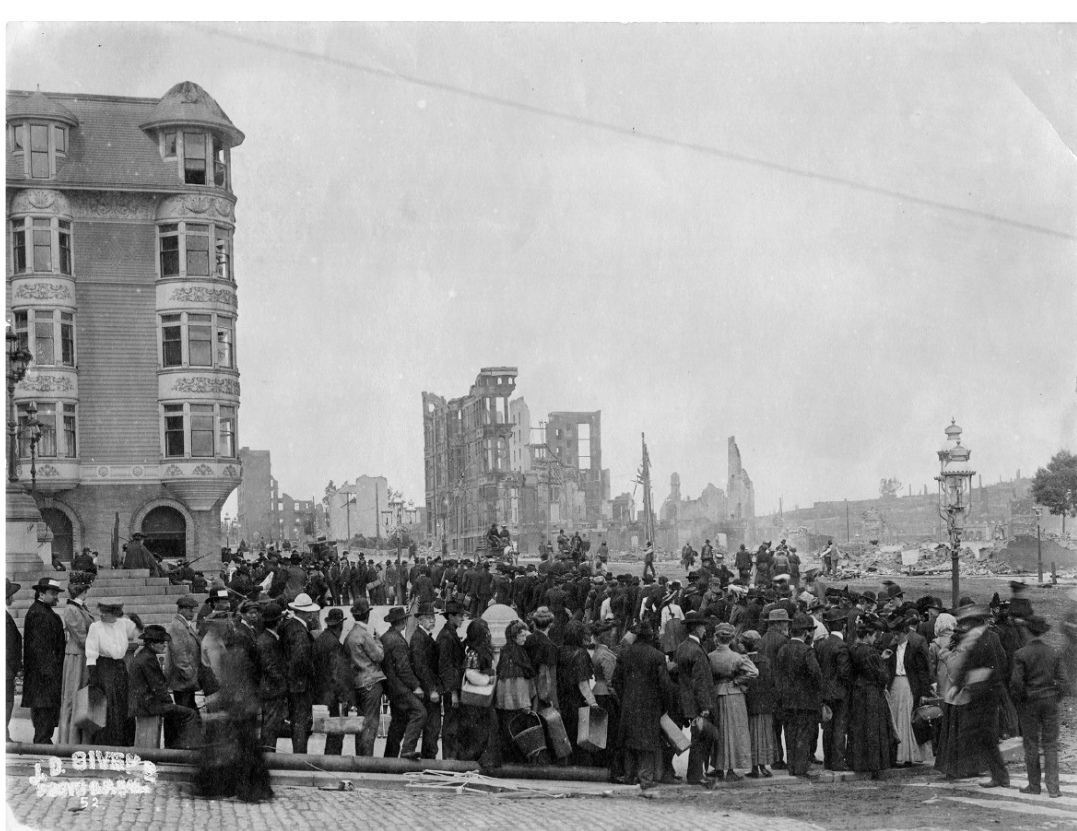
Figure 2: 1906 photograph showing a bread line at St. Mary’s